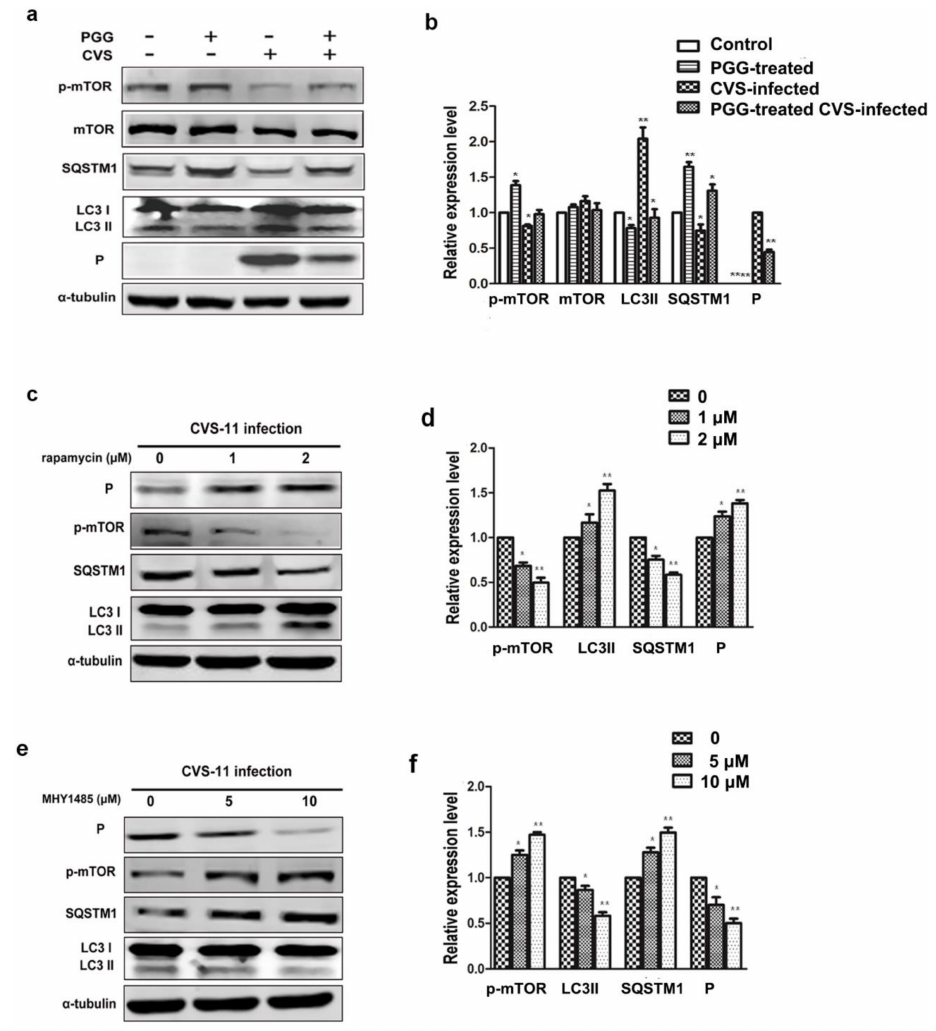
Figure 6. PGG inhibits the replication of RABV via mTOR-associated autophagy. ( a ) mTOR pathway-associated proteins and autophagy markers were analyzed by Western blotting, after CVS-infected BHK-21 cells treated with PGG for 24 h. ( b ) The relative expression levels of mTOR, p-mTOR, SQSTM1, LC3, and viral P protein, normalizing to that of α -tubulin. BHK-21 cells were pretreated with rapamycin (1 or 2 µ M) or MHY1485 (5 or 10 µ M) for 1 h, then infected with CVS-11 and cultured in medium containing rapamycin or MHY1485 for 24 h. ( c , e ) p-mTOR, autophagy markers, and P protein were analyzed by Western blotting. ( d , f ) The relative expression levels of p-mTOR, SQSTM1, LC3, and viral P, normalizing to that of α -tubulin. (* p < 0.05; ** p <